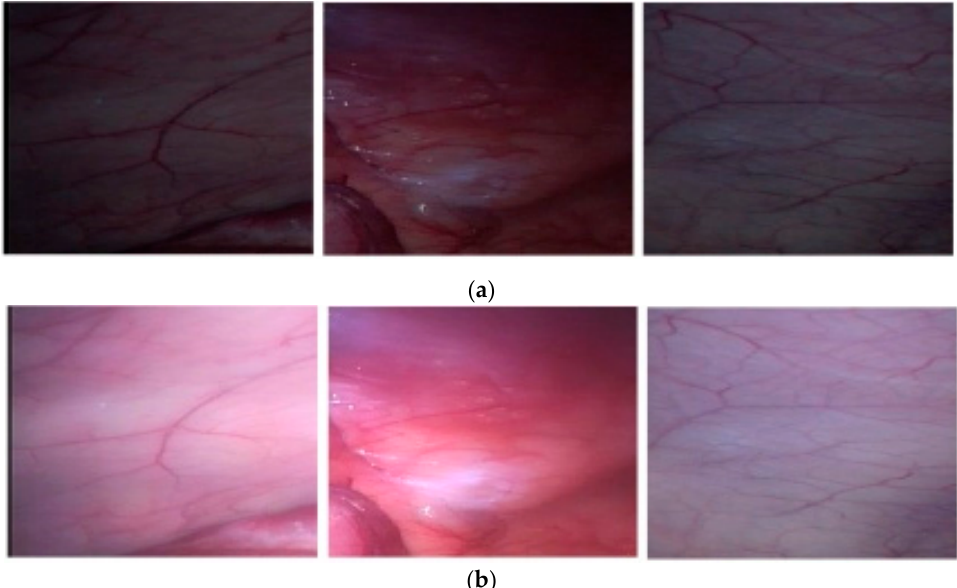
Figure 4. Comparison of brightness enhancement effects: ( a ) original images and ( b ) after brightness enhancement.